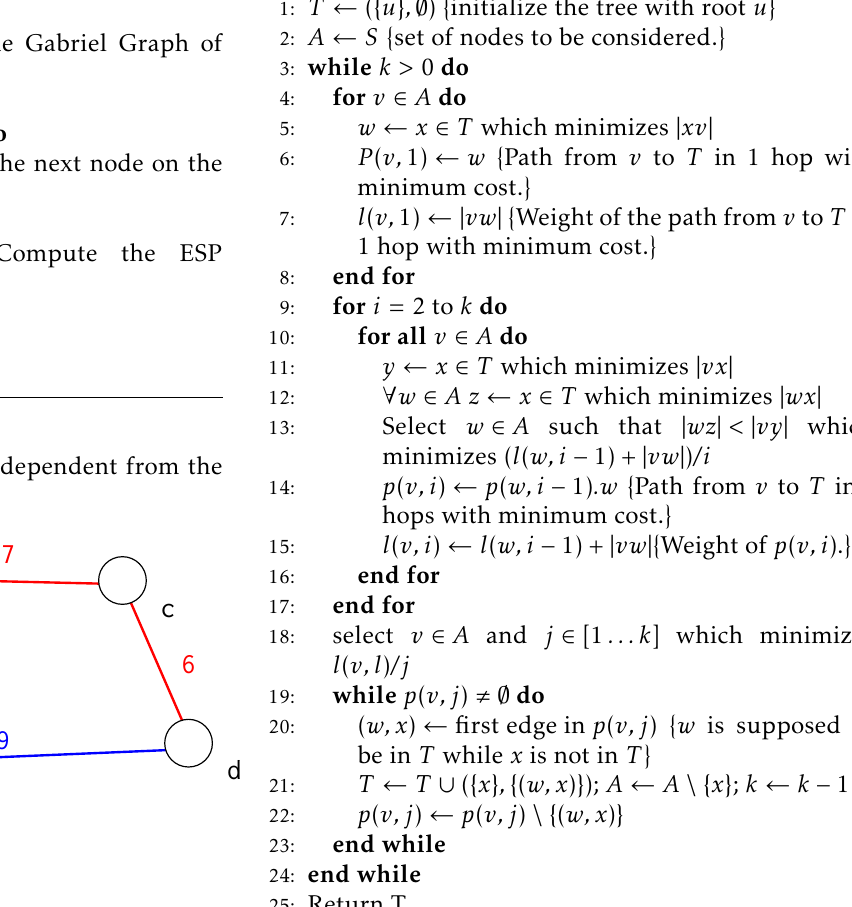
Algorithm 3 k-MST( u; S; k ) – Return a k -MST of S ∪ { u } rooted in u